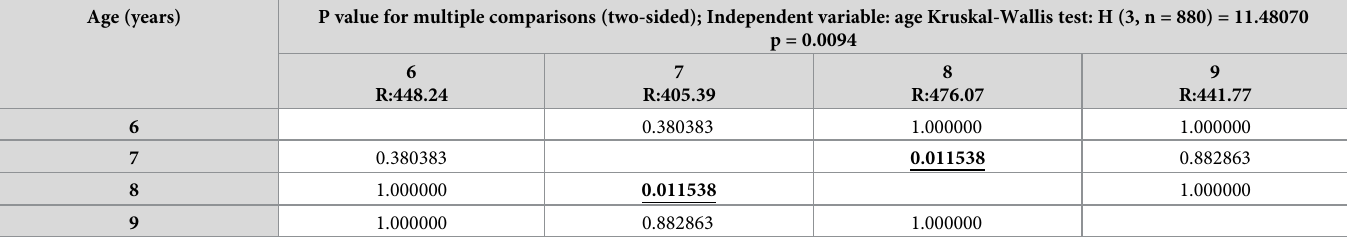
Table 3. The post hoc analysis of differences among age groups, in terms of the number of tests with abnormal results, for group”S”. Age (years) P value for multiple comparisons (two-sided); Independent variable: age Kruskal-Wallis test: H (3, n = 880) = 11.48070 p =